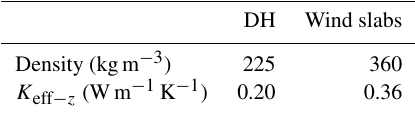
Table 2. End-of-season properties for DH and wind slabs.